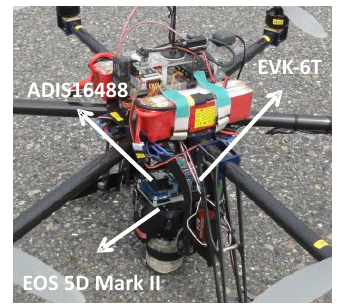
Figure 2 Configuration of DG module